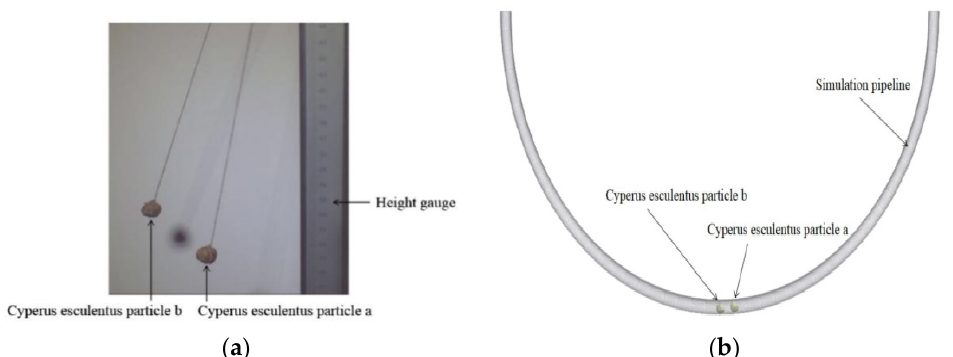
Figure 9. Test and simulation test diagram of walnut crash coefficient of recovery. ( a ) Test; ( b ) Simulation [100].